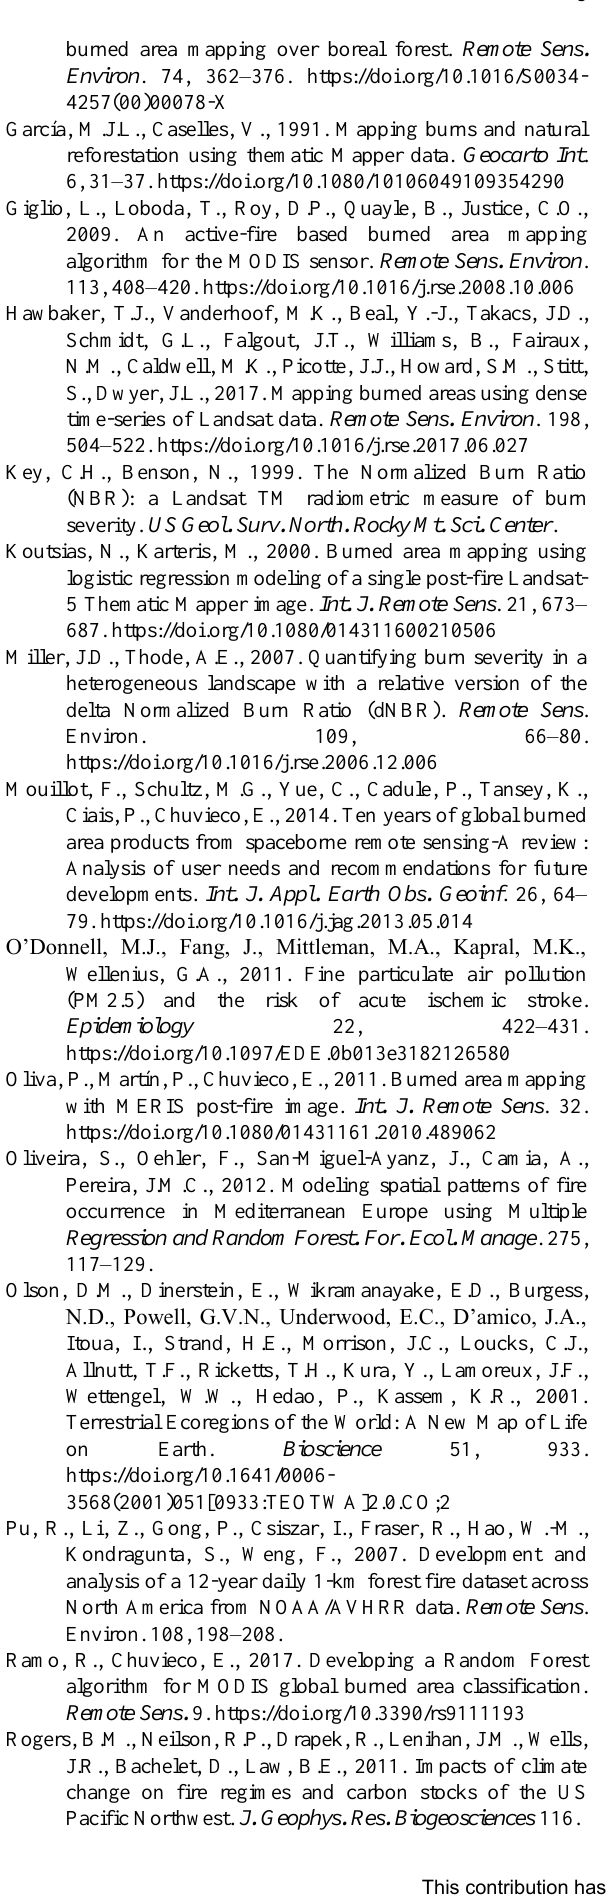
Key, C.H., Benson, N., 1999. The Normalized Burn